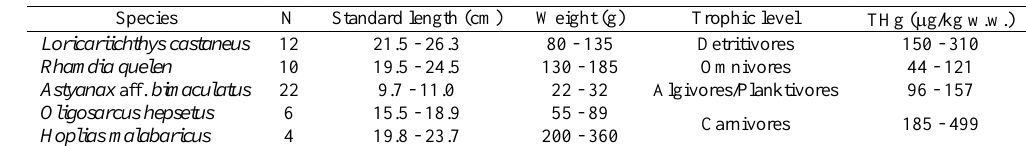
Table 1. Minimum and maximum values of total mercury concentration (THg) in muscle, and sizes of fish from Vigário reservoir. (N) number of specimens